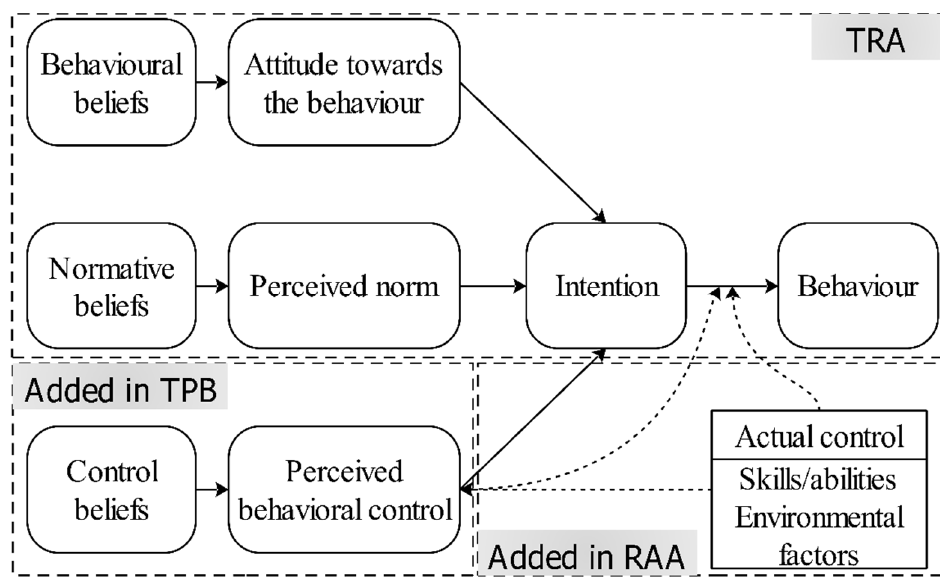
Figure 5. Simplified formation of the Reasoned action model from two other well-known behav- ioural models